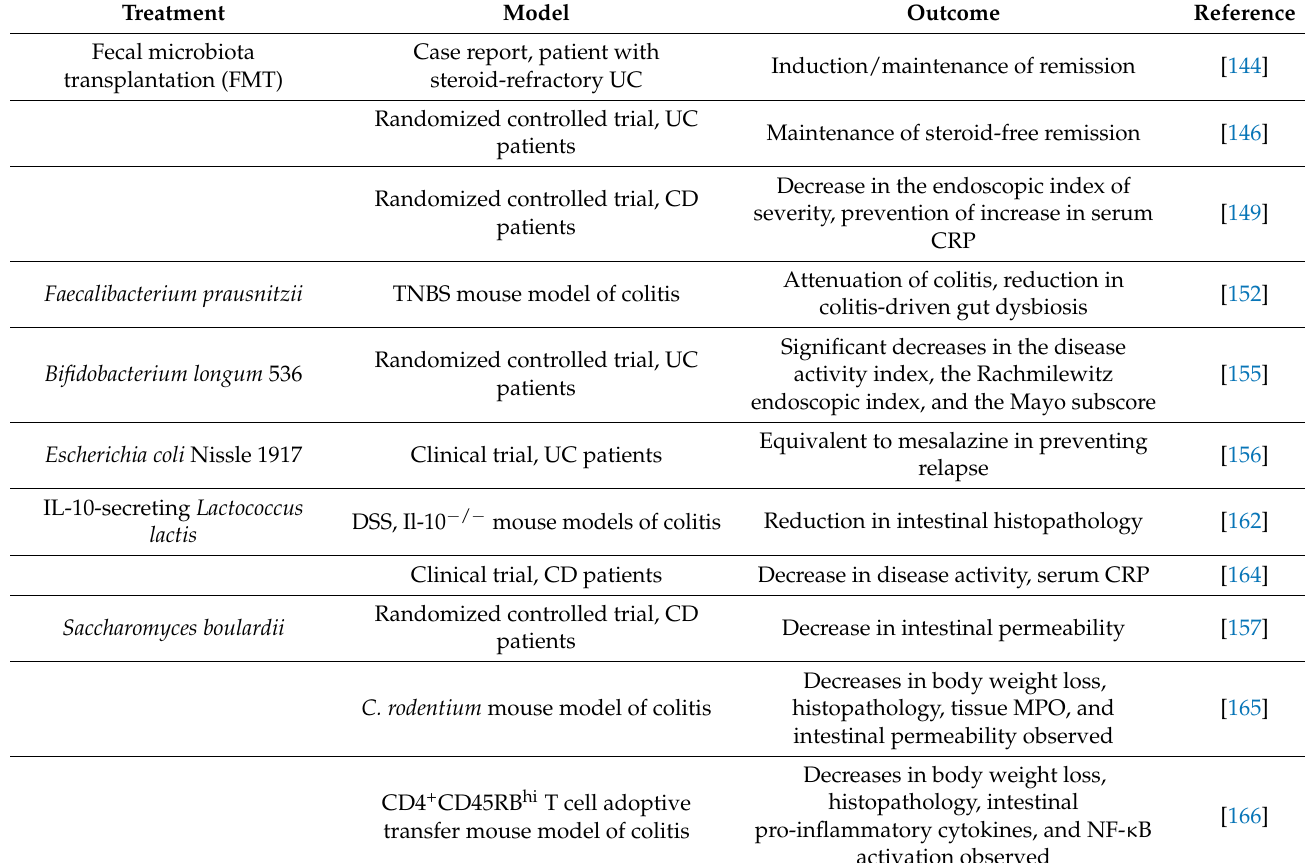
Table 1. List of intestine-protective interventions described in this